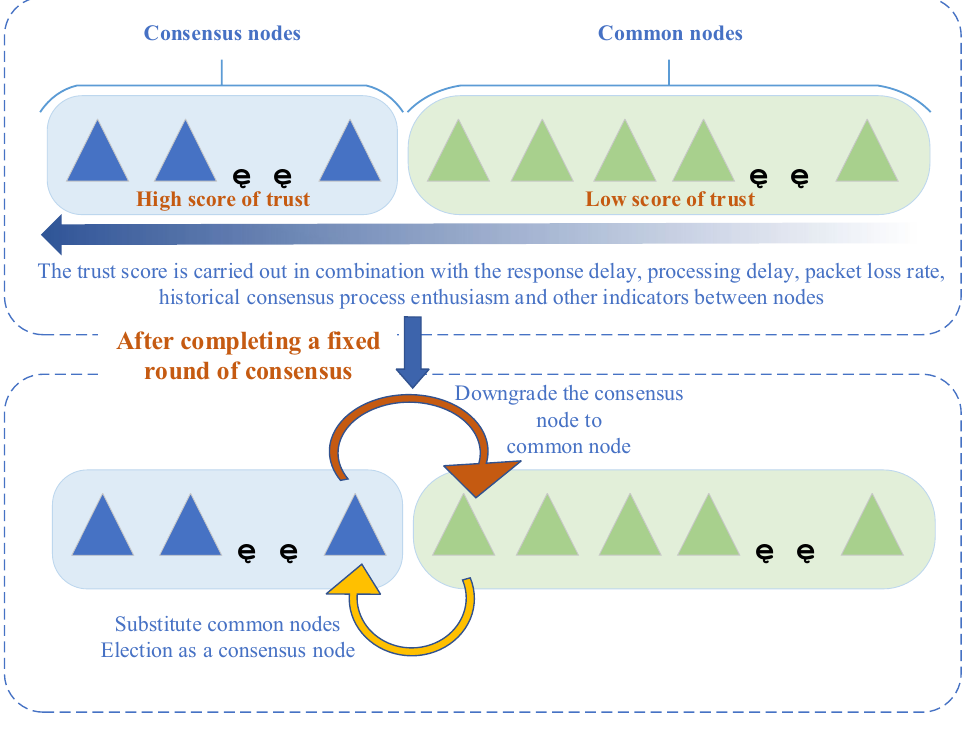
Figure 3. Node trust equity scoring